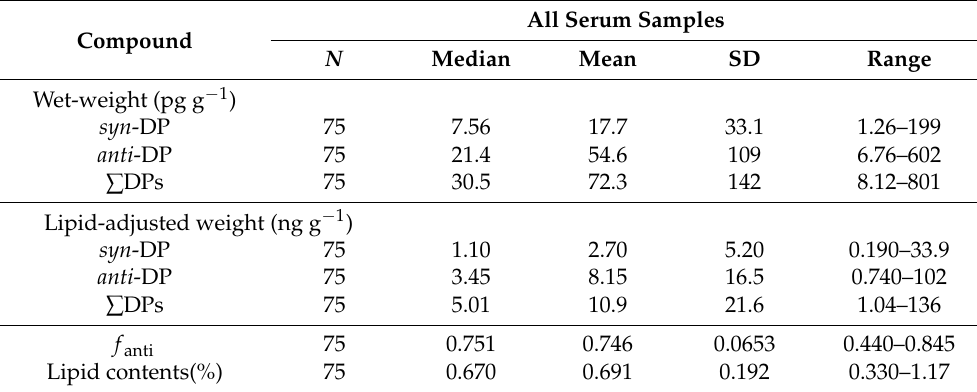
Table 1. Descriptive statistics for dechlorane plus (DP) and serum lipid contents measured in all serum samples of pregnant